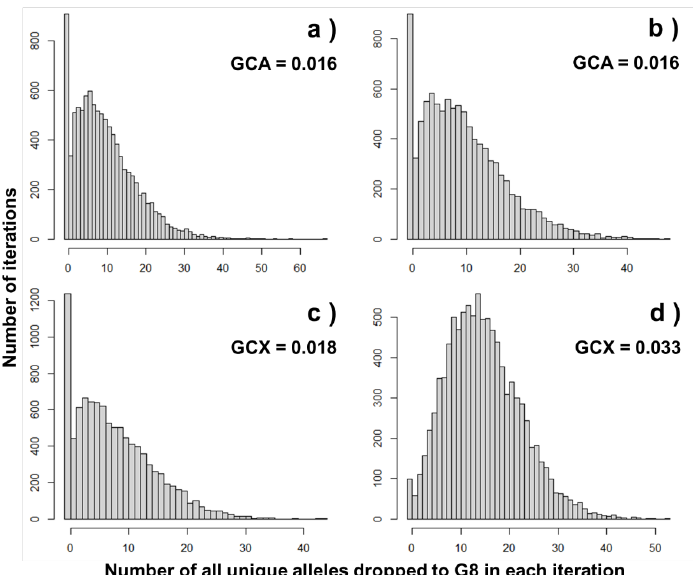
Figure 4. Distribution of the number of alleles of G1 mice inherited to G8 in gene-dropping simulation: ( a ) shows the histogram of the number of dropped alleles of autosomal genes of the G1 male with the highest GCA I,popB to G8, ( b ) shows the histogram of the number of dropped alleles of the G1 female with the highest GCA I,popB to G8, ( c ) shows the histogram of the number of dropped gene alleles on the X chromosome of the G1 male with the highest GCX I,popB to G8, and ( d ) shows the histogram of the number of dropped gene alleles on the X chromosome of the G1 female with the highest GCX I,popB to